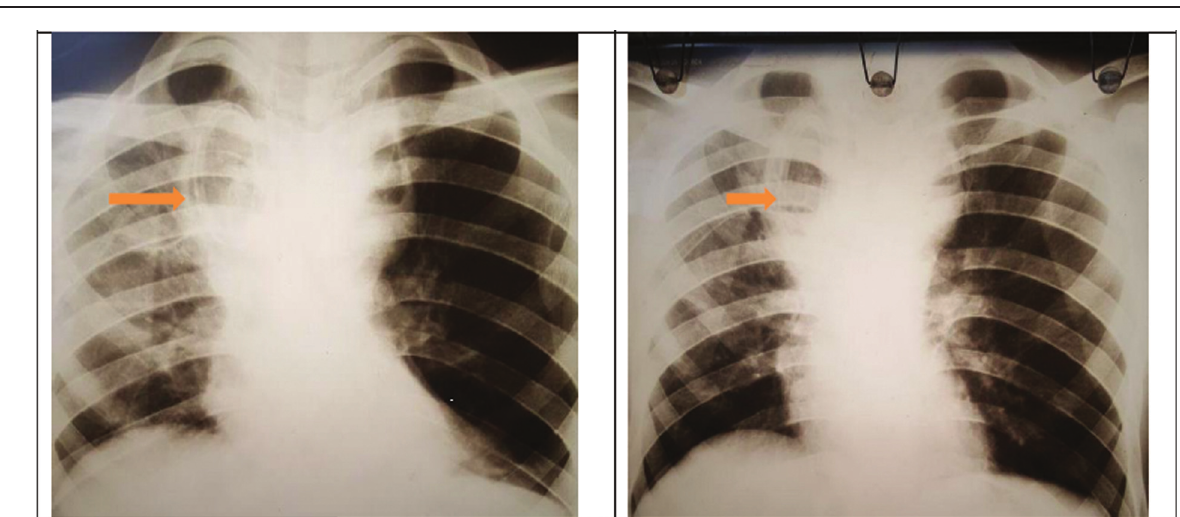
Chest radiography showing the opaque drainage tube in the